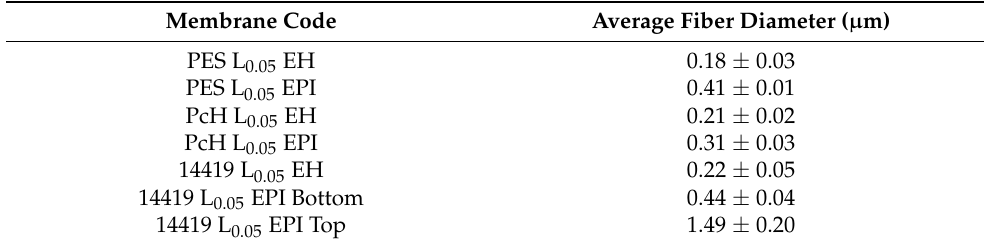
Table 2. Average fiber diameter ( µ m) of the fabricated membranes.